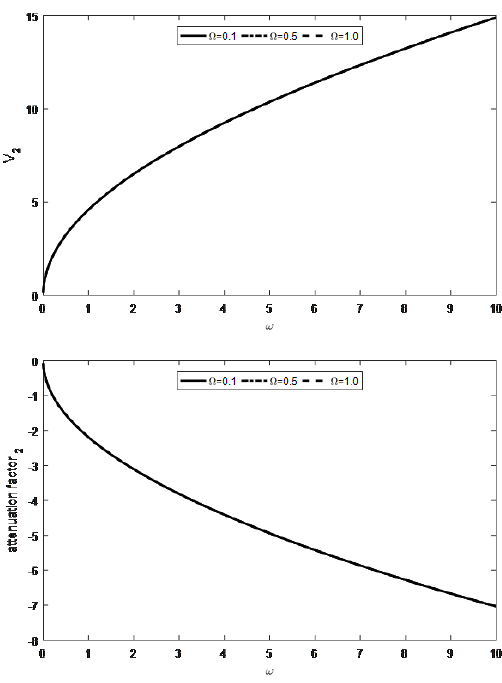
Figure 11: Velocity and attenuation factor for different values of ω and rotational frequency